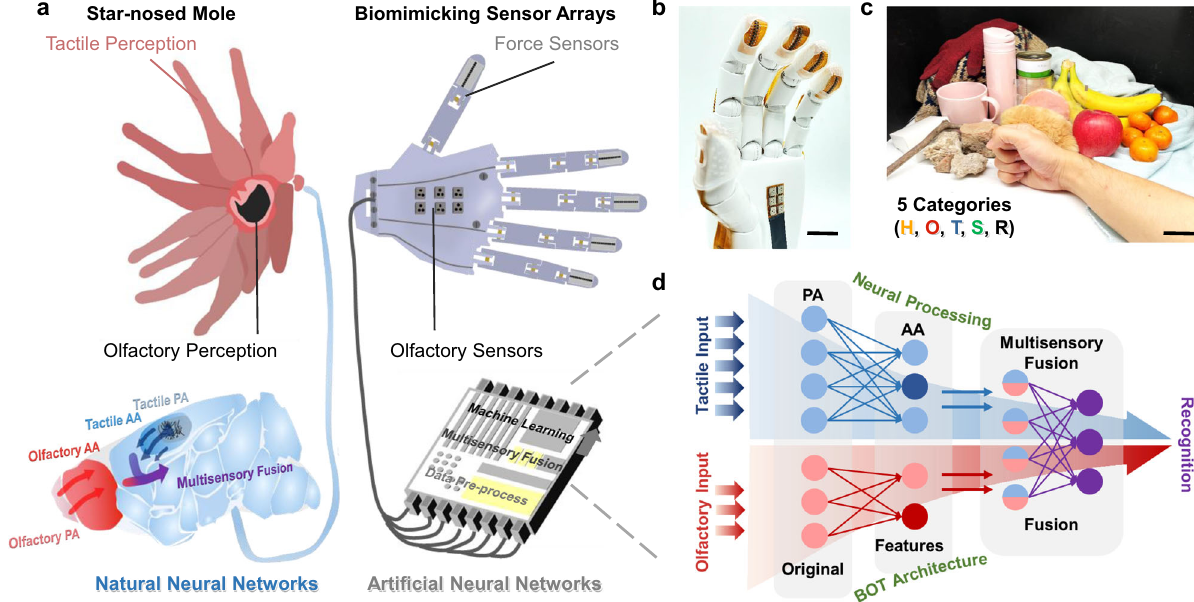
Fig. 1 Bioinspired tactile-olfactory associated intelligent sensory system. a Schematic illustration of the bio-sensory perceptual system in the star-nosed mole (left) and biomimicking intelligent sensory system (right). Top left: diagram of the unique structure of the star-shaped nose. Bottom left: Scheme showing the processing hierarchy of tactile and olfactory information in the neural system of the star-nosed mole. Blue and red areas represent the processing region (PA, primary area; AA, association area) for tactile and olfactory information, respectively. Blue and red arrows represent the direction of tactile and olfactory information fl ow; the purple arrow shows the information fl ow of the multisensory fusion. Top right: schematic diagram of the sensing array on the mechanical hand, including force and olfactory sensors. Bottom right: illustration of arti fi cial neural networks. Images of the mechanical hand with scale bar of 2 cm ( b ) and eleven different objects to be identi fi ed, scale bar: 3 cm ( c ). Objects to be tested can be divided into fi ve categories including Human ( H , main target), Olfactory interference ( O , e.g., worn clothes), Tactile interference ( T , e.g., mouse), Soft objects ( S , e.g., fruits), and Rigid objects ( R , e.g., debris). d The machine learning framework consists of three connected layers of neural networks that mimic the multisensory fusion process hierarchy. Top left: early tactile information processing. Bottom left: early olfactory information processing. Right: neural network resembling the high-level fusion of tactile and olfactory